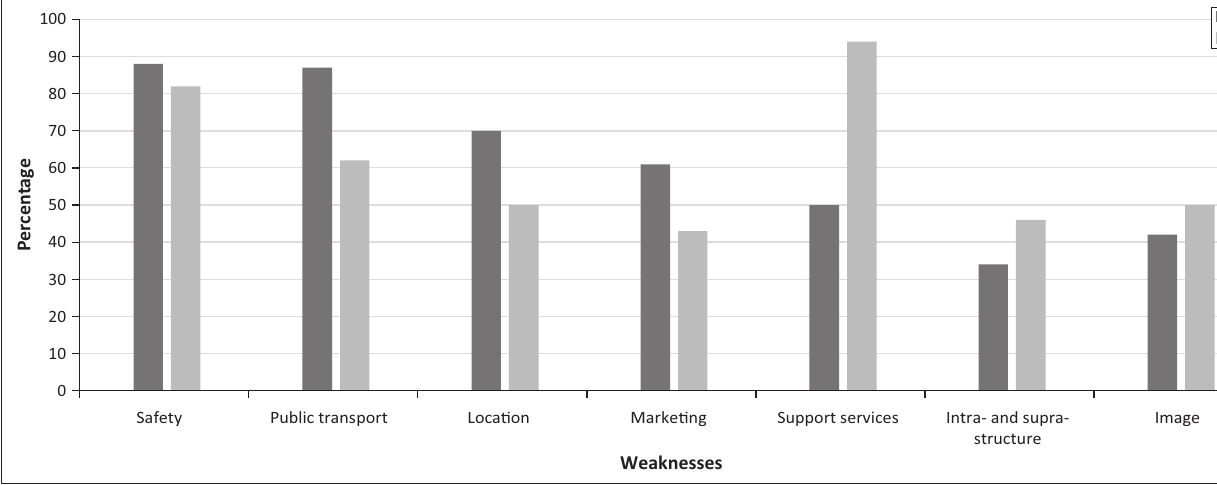
FIGURE 5: Comparison of South Africa’s main weaknesses in 2002 and 2013. TABLE 1: Factor analysis of competitiveness factors of South Africa as a tourist destination. Factors of